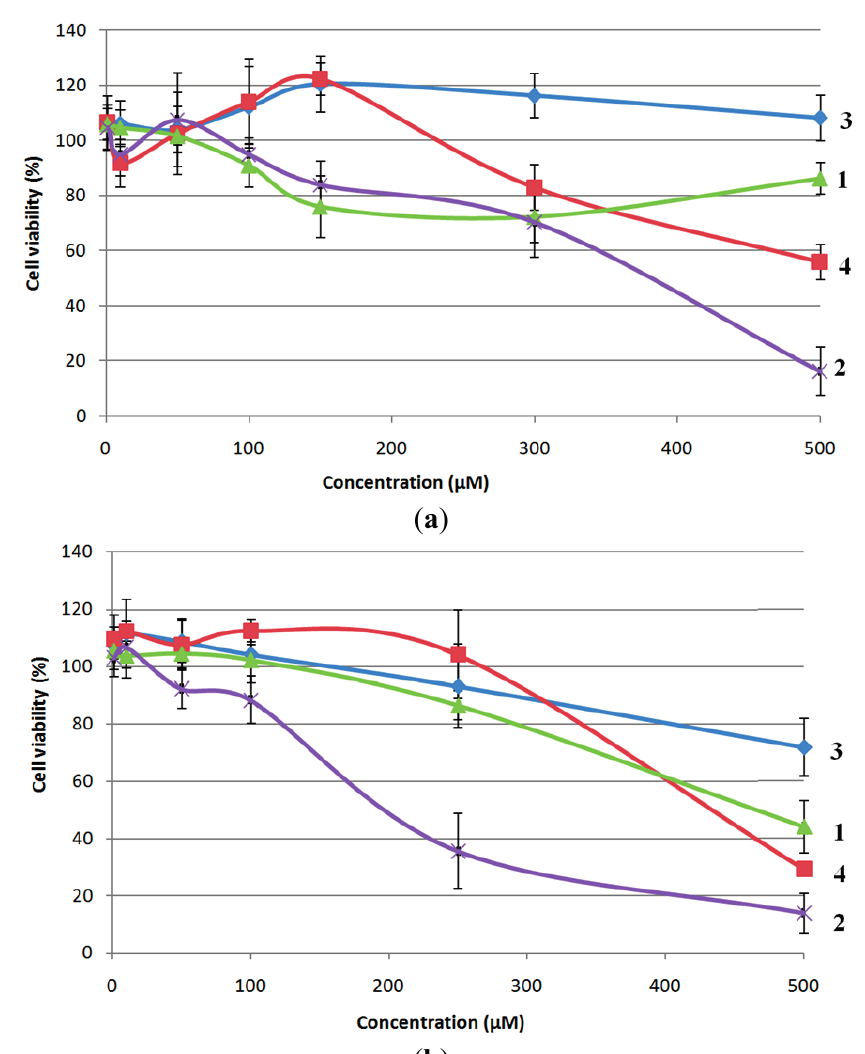
Figure 10. Effects of four different compounds on MCF-7 ( a ) and HeLa ( b ) cells viability assessed by the WST-1 assay. Values were represented as the mean ± SD from three independent